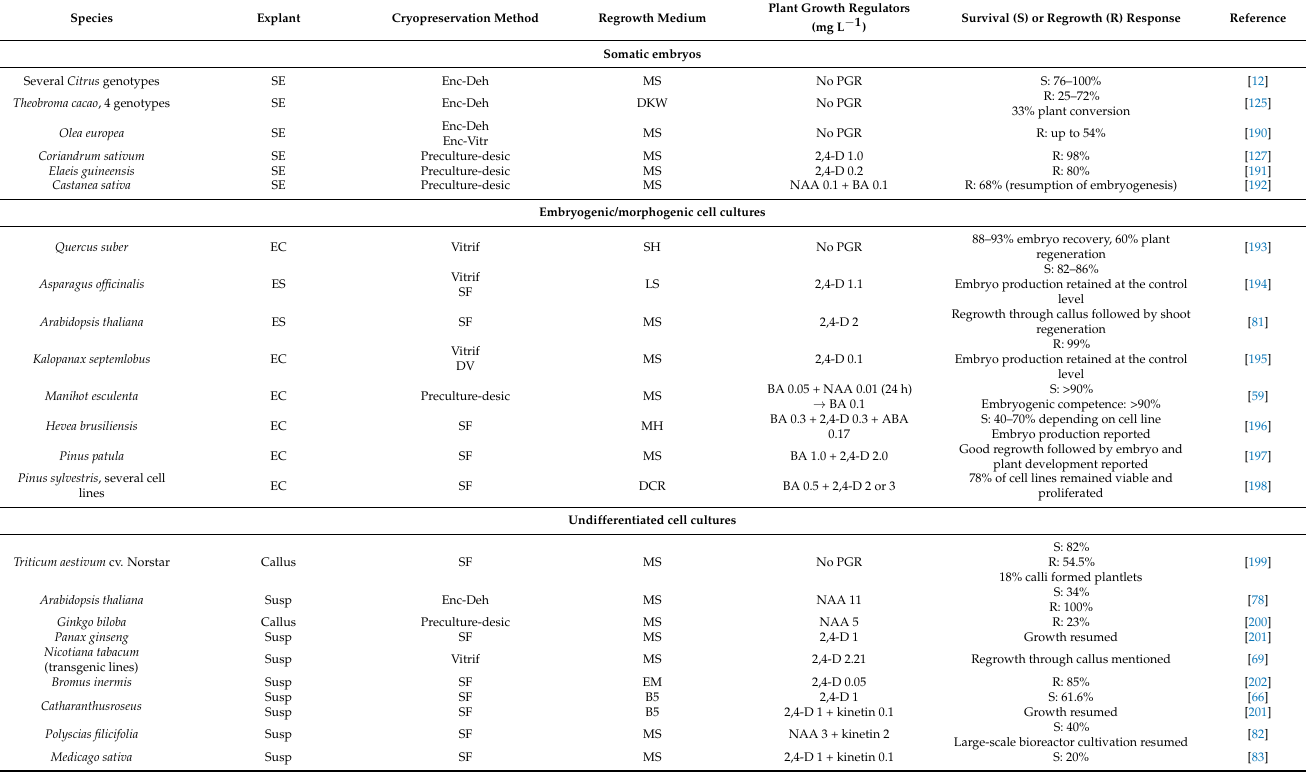
Table 4. Examples of plant growth regulators used at the recovery step during cryopreservation of somatic embryos, embryogenic and non-embryogenic (undifferentiated) cell